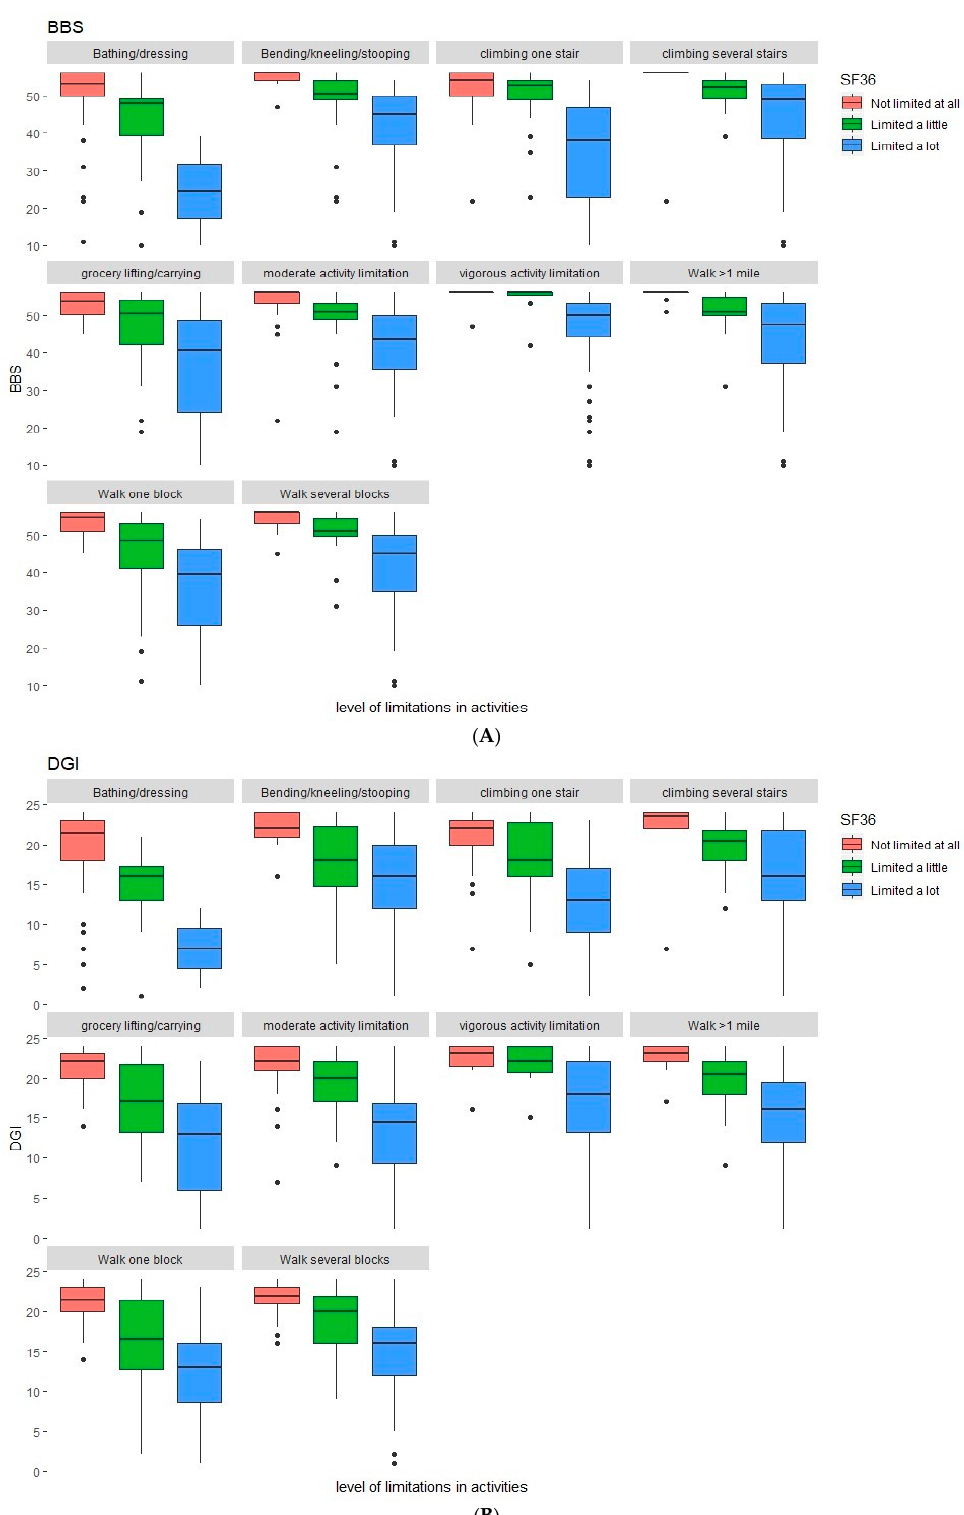
Figure 1. The BBS and DGI relationship items of SF-36 Physical Functioning. Panel ( A ): BBS and SF-36 Physical Functioning Items. Panel ( B ): DGI and SF-36 Physical Functioning Items. There was a strong partial correlation of 0.823 (CI: 0.733, 0.885) between the DGI and BBS in the overall sample. The partial Spearman correlations between the DGI and BBS with other